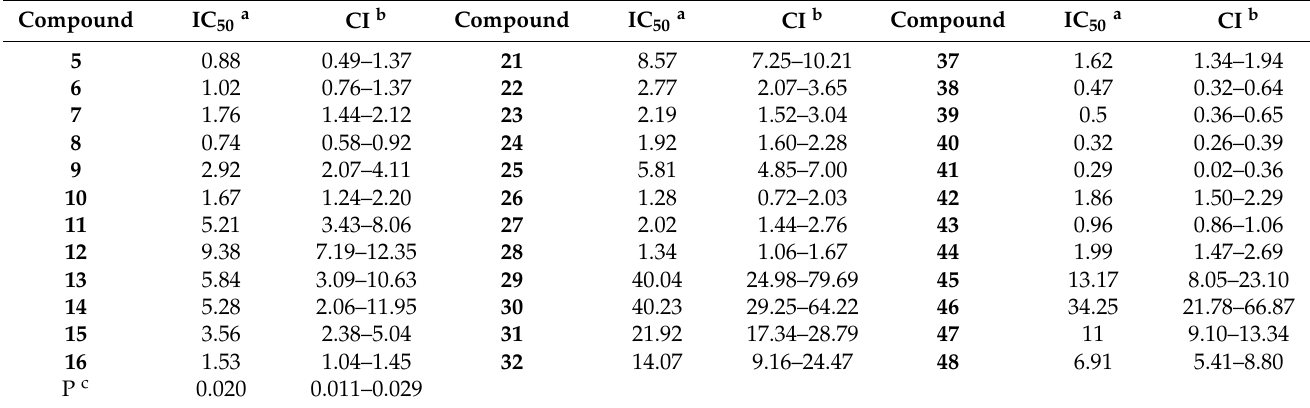
Table 2. In vitro antifungal activity of enamine-type Schiff bases 1–48 against Fusarium oxysporum